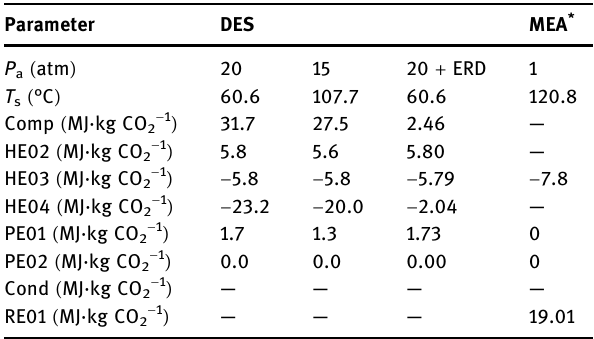
Table 8: Comparison between the speci fi c energy demand of the MEA and DES